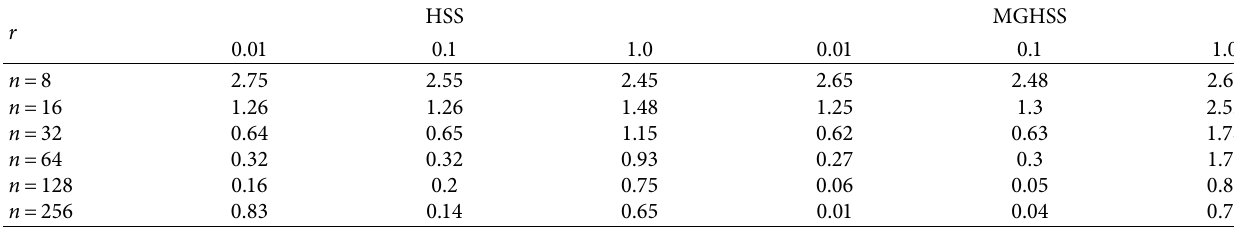
and β for HSS and MGHSS. exp exp